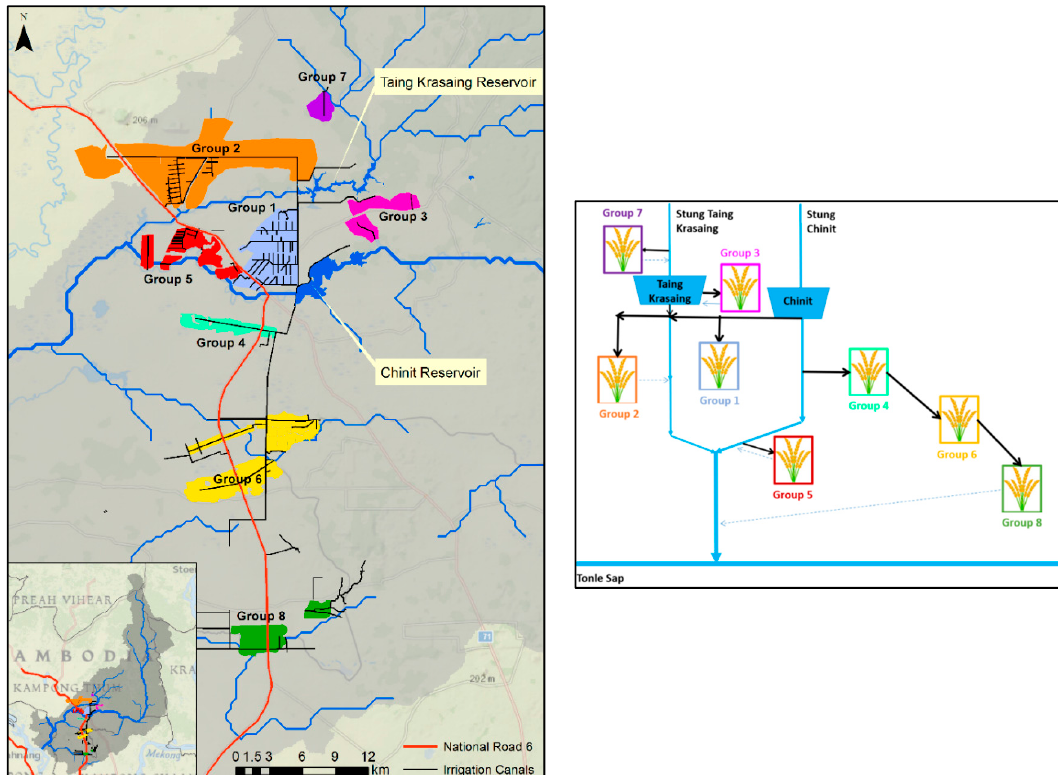
Figure 4. Map of Chinit and Taing Krasaing reservoirs and irrigation schemes ( left ). Inset map shows the entire Stung Chinit watershed, in grey. Schematic of Chinit and Taing Krasaing reservoirs and command area groups ( right ). Canals are represented by black lines, rivers are represented by blue lines and drainage from the fields is shown by the dotted blue lines. Arrows show how each group receives water from the rivers and reservoirs via canals. Table 4. Characteristics of the two reservoirs represented in the